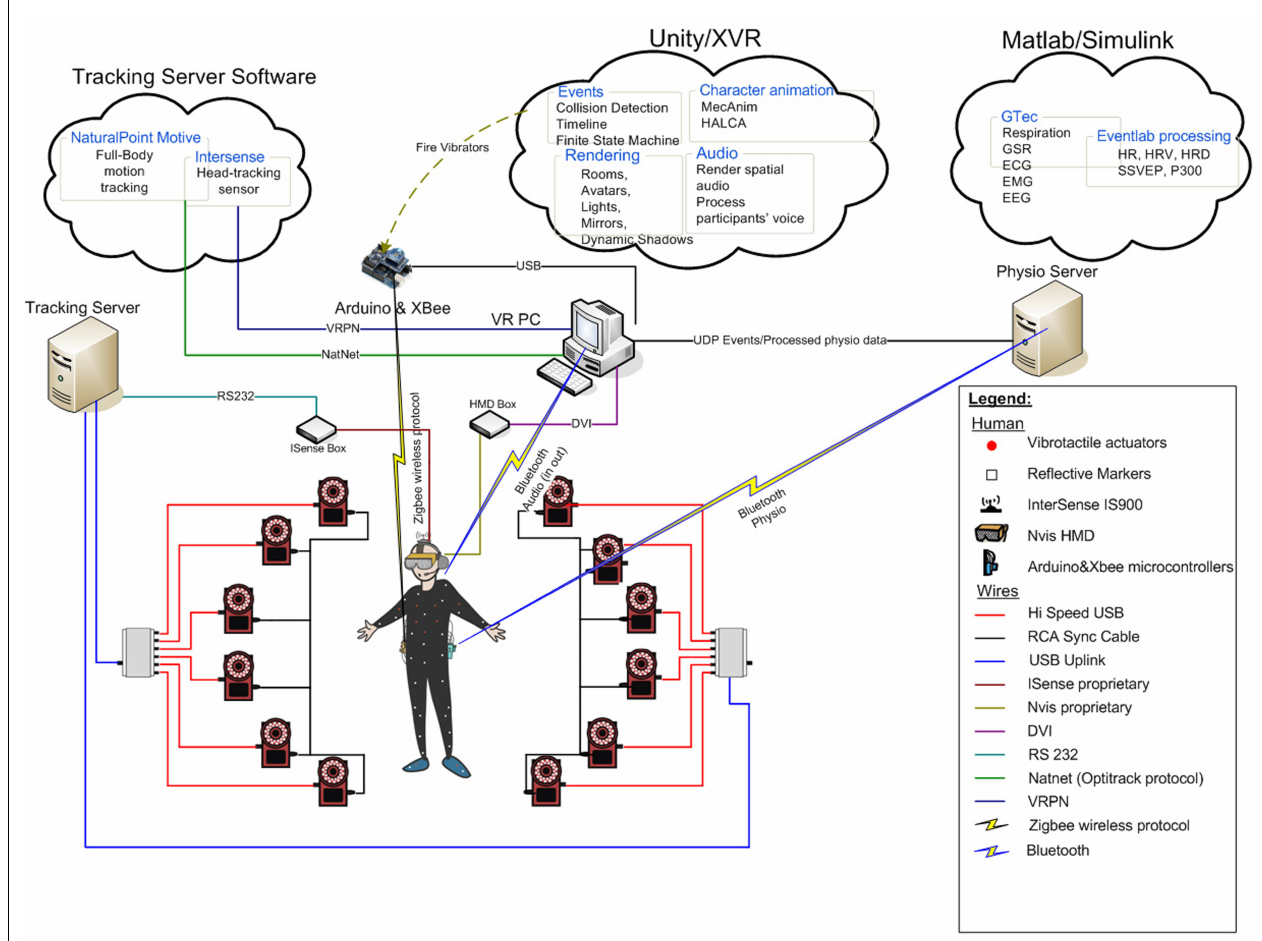
FIGURE 2 |An overview of the embodiment system . In the center the participant is shown with head-tracking and an optical full body tracking suit, wearing devices for physiological measurements, vibrotactile haptic actuators for haptic response, a HMD for showing the stereo imagery and a headset with microphone for delivering and recording